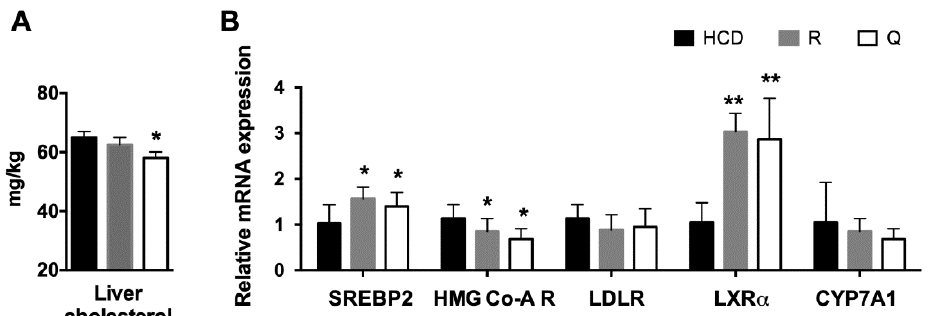
Figure 6. Effects of rutin (R) and quercetin (Q) on cholesterol modulation in hamsters fed a high-cholesterol control diet (HCD) or one of two experimental diets containing R and Q. At week 8: ( A ) liver cholesterol; and ( B ) mRNA expression level of cholesterol-related genes of the hamsters. Data were normalized with GAPDH. Values are expressed as means ± standard deviations (n = 8). ** p < 0.01; or * p < 0.05 compared with the control group.